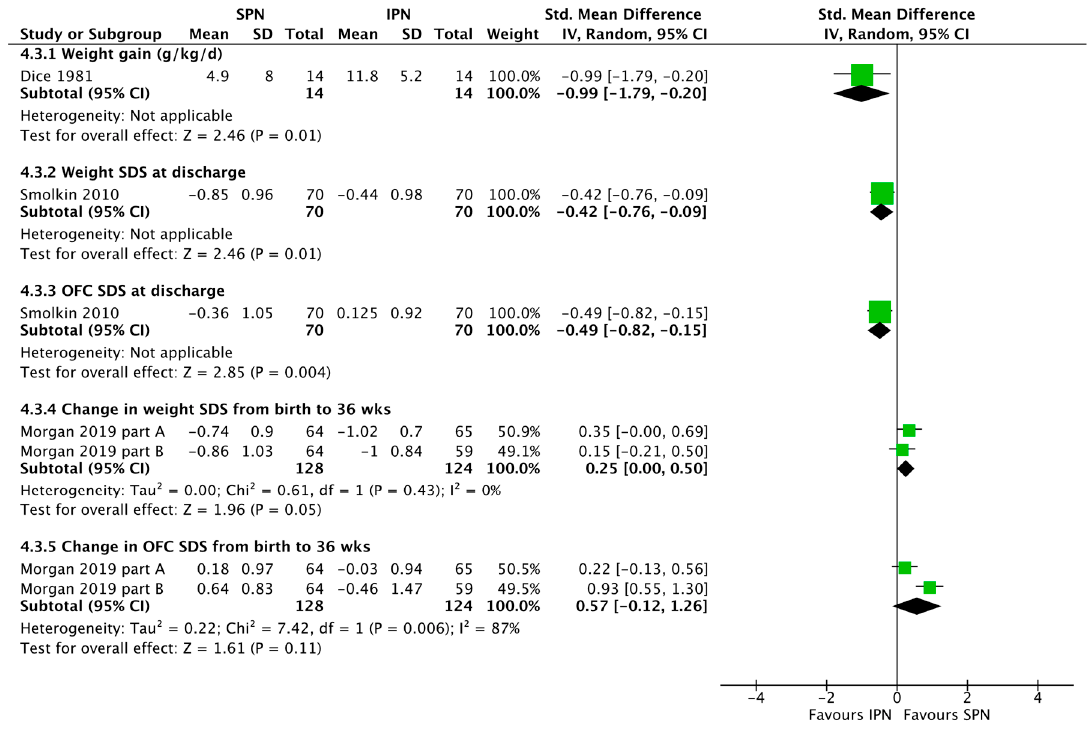
Figure 5. Forest plot on the effect of standardized parenteral nutrition (SPN) vs. individualized parenteral nutrition (IPN) on growth. Green squares represent individual studies, diamonds represent subgroup analyses.